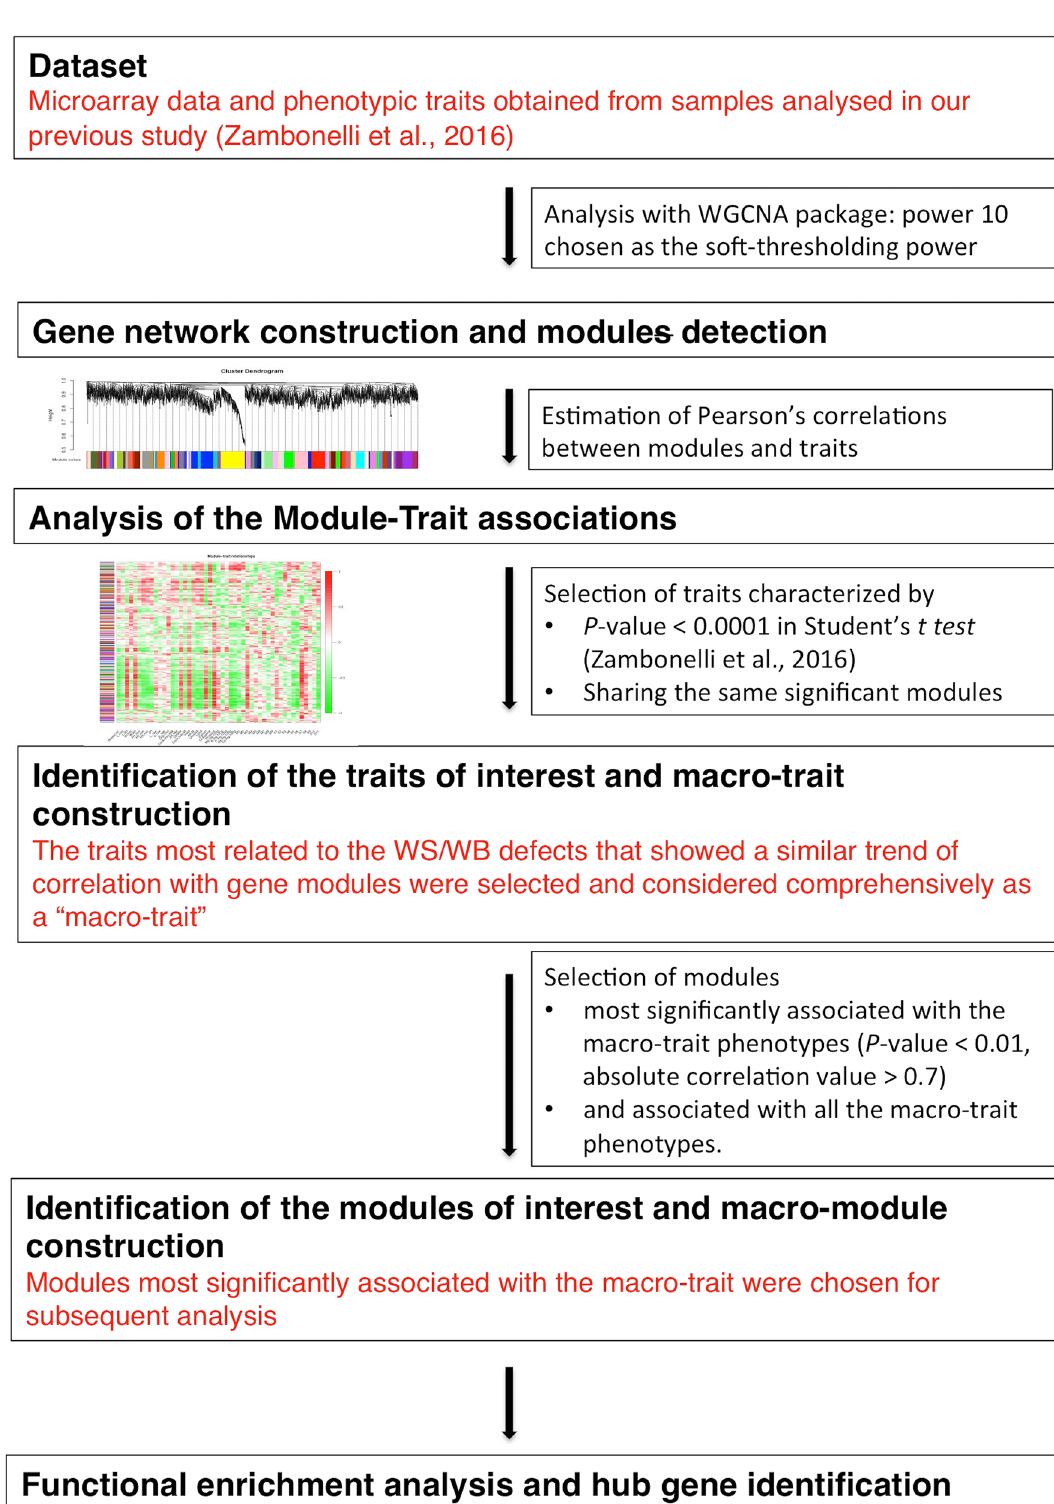
Figure 5. Flowchart of the performed analysis. The scheme shows the steps of the gene network construction, identification of traits and modules of interest and analysis of the data obtained by